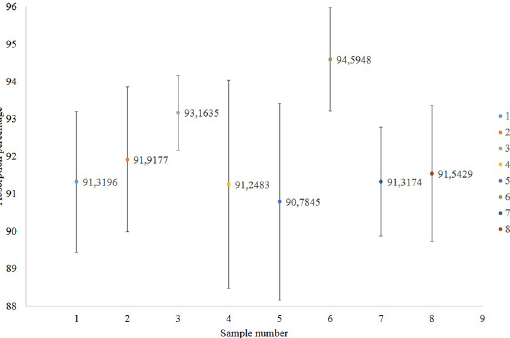
Figure 3. Average and standard deviation of the absorptance for the different absorber films deposited on steel substrates.